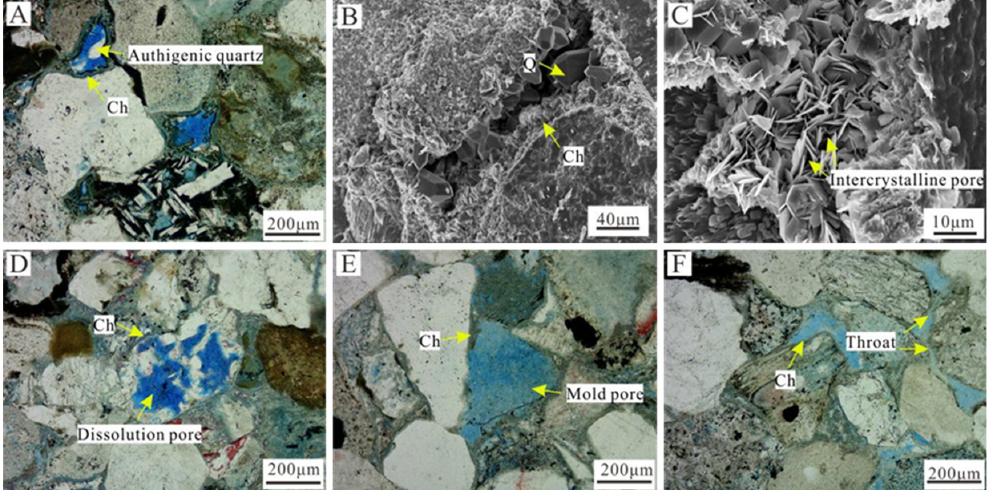
Figure 13. Relationship between authigenic chlorite and macroscopic pores. ( A ) Intergranular pores surrounded by pore-lining chlorite are filled with authigenic quartz, well Bei 202, 3112.75 m. ( B ) Intergranular pores surrounded by pore-lining chlorite are filled with authigenic quartz, well Bei 202, 3101.4 m. ( C ) Authigenic chlorite has a large number of intercrystalline pores, well Bei 202, 3125 m. ( D ) Intragranular dissolution pores of feldspar particles, well Bei 202, 3087.33 m. ( E ) Mold pore surrounded by pore-lining chlorite, well Bei 202, 2994 m. ( F ) The compaction effect is weak, and part of the throat is preserved, well Bei 202, 2994